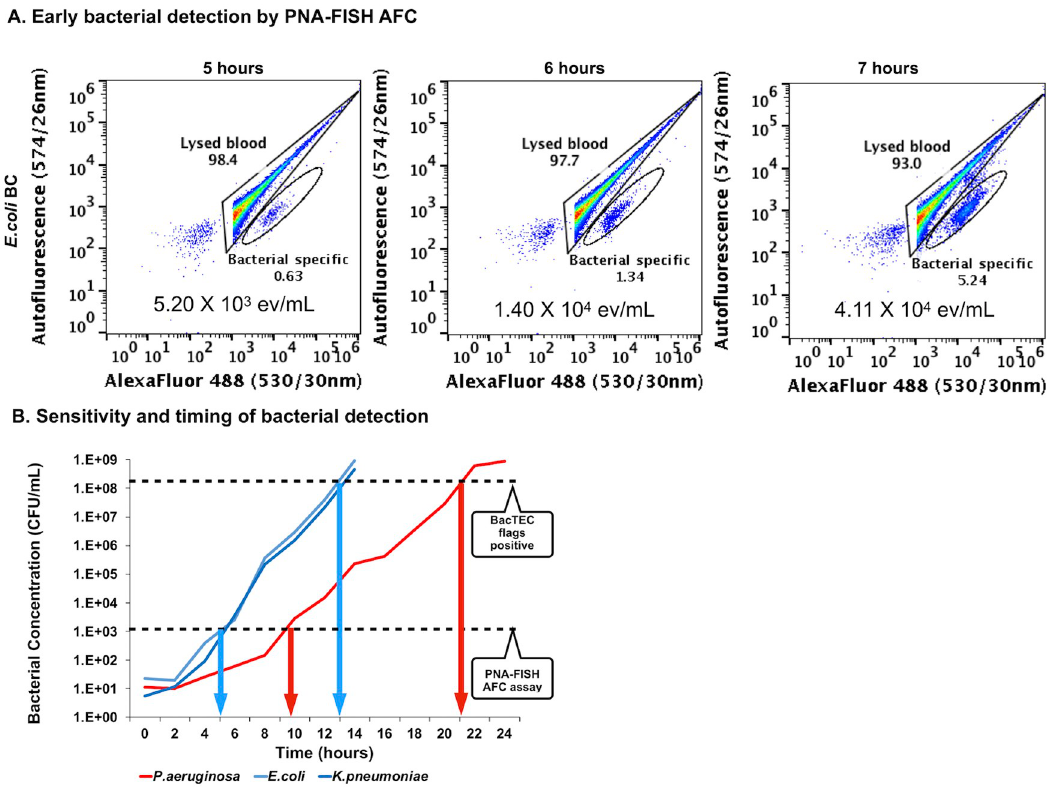
Fig 5. Early bacterial detection in BC with PNA-FISH-AFC. A : Detection of E . coli by PNA-FISH enhanced AFC in spiked BC following incubation on the BacTEC FX system. A 9-time increase in number of events was observed in the bacteria-specific gate from 5 to 7 hours of incubation indicating actively growing bacterial population. B : Growth curves of bacteria in spiked BC on the BacTEC system. Two fast growing bacterial species, E . coli and K . pneumoniae , and one slow grower, P . aeruginosa , were incubated on the BacTEC FX system. The 2-hourly determined plate counts ( y -axis, CFU/mL) were used to produce growth curves, while the appearance of bacteria-specific events by PNA-FISH enhanced AFC was monitored hourly for the first 12 hours of incubation. The overall positivity on the BacTEC system was also monitored in parallel. Bacteria-specific signal by PNA-FISH-AFC was first observed at 5 and 10 hours of incubation for the fast ( E . coli , K . pneumoniae ) and slower growing bacterial species ( P . aeruginosa ), respectively. This was confirmed by three independent experiments. The positivity on the BacTEC system was reached at approximately 13 hours and 21 hours of incubation for the fast and slow growers, respectively, also confirmed by three independent experiments with slight variations between experiments. The horizontal broken lines indicate the sensitivity of the PNA-FISH-AFC at 10 3 − 10 4 CFU/mL, and for the BacTEC system at 10 8 − 10 9 CFU/mL. The time gained by the PNA-FISH assay when compared to BacTEC positivity was 8 hours for fast growers, as indicated by blue arrows, and 10 hours for slow grower, as indicated by red arrows, respectively.